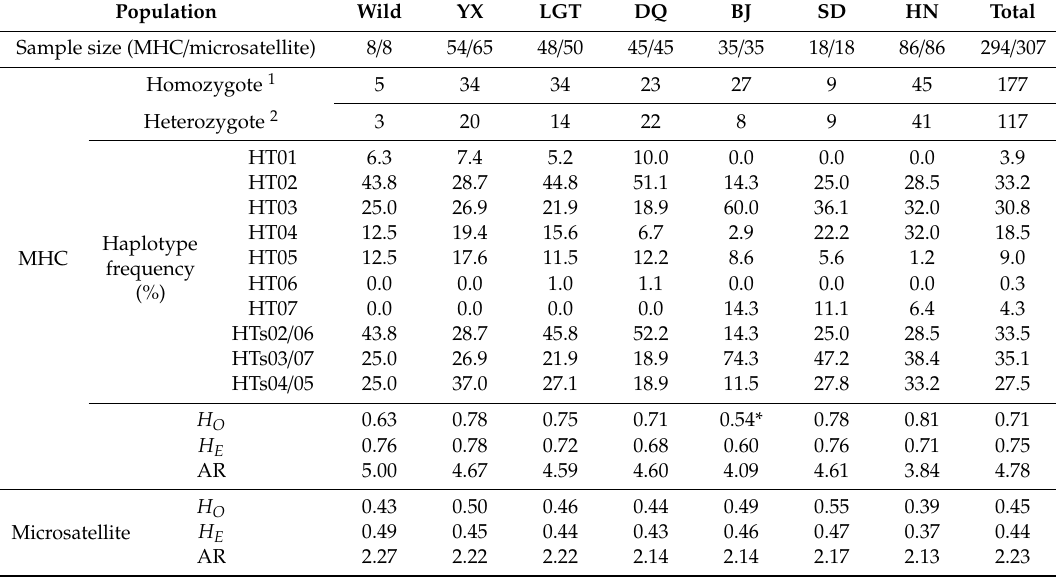
Table 2. Summary of genetic variation and haplotype frequencies across seven populations of crested ibis. Population